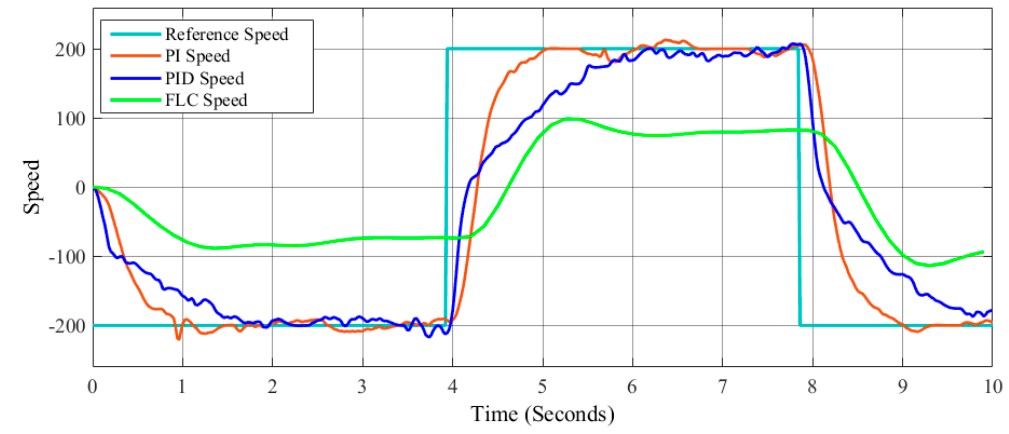
Figure 23. Graphic representation of the best result obtained.